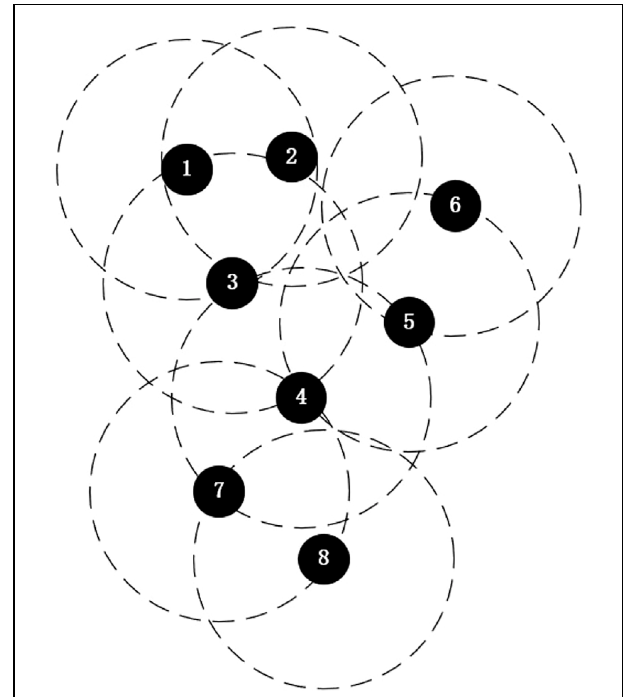
FIGURE 5 | Eight USV ad hoc network structure diagram.